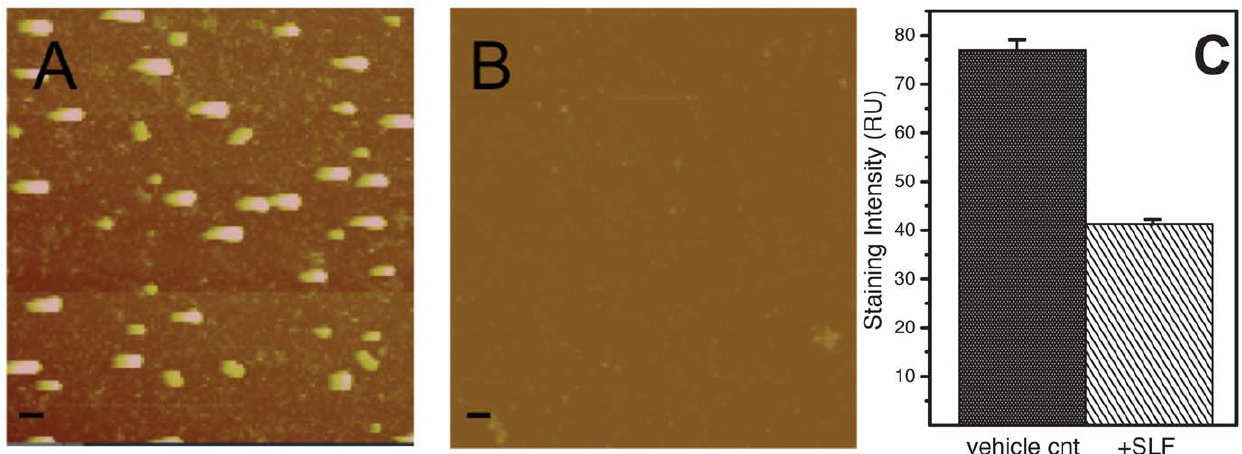
Figure 5. Clearance of A b O aggregates observed by AFM imaging and ThT binding assay. Small oligomers used in this study are formed within 60 minutes (scale bar 10 nm). The direct visualization of oligomers by using AFM revealed the formation of A b O aggregates. (A) 50 m M of A b after 24 hours of incubation at room temperature (diameter 5–10 nm). B) 50 m M of A b and 50 m M of SLF after 24 hours of incubation at room temperature. (C) Staining for beta-rich assemblies by the amyloid dye thioflavin T for incubations of A b with and without SLF HO-4160 as described in Methods. Data are the averages from 3 separate experiments with the error bars representing the SEM.